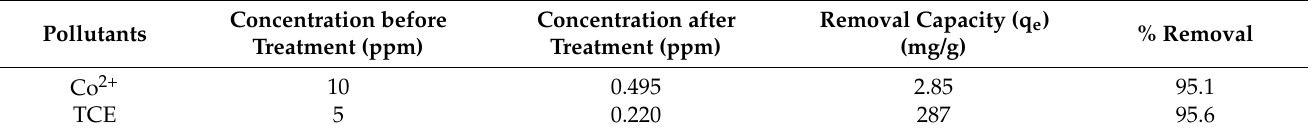
Table 2. Mine effluent wastewater treated using the developed nanobiocomposite